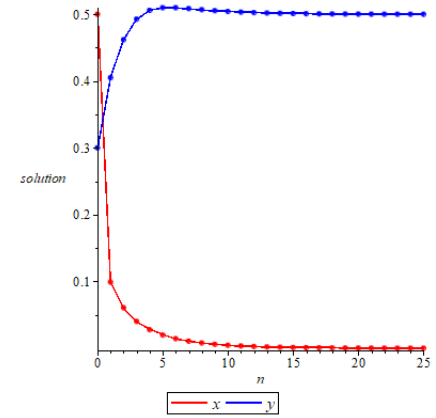
Figure 5. Local stability of prey-free equilibrium.